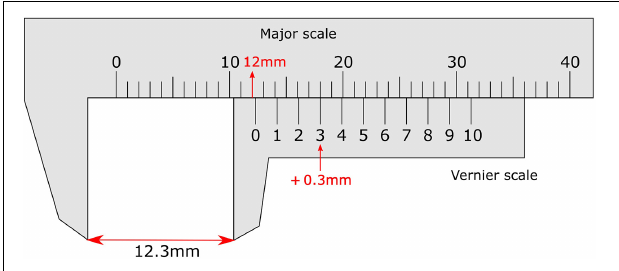
FIGURE 1 | Vernier calliper with a vernier scale on the sliding secondary scale. On the vernier scale the zero line provides the reading before the decimal point (12 mm), while the non-zero line (3) that aligns most closely with a line on the major scale provides the reading after the decimal place. This totals a measurement of 12.3